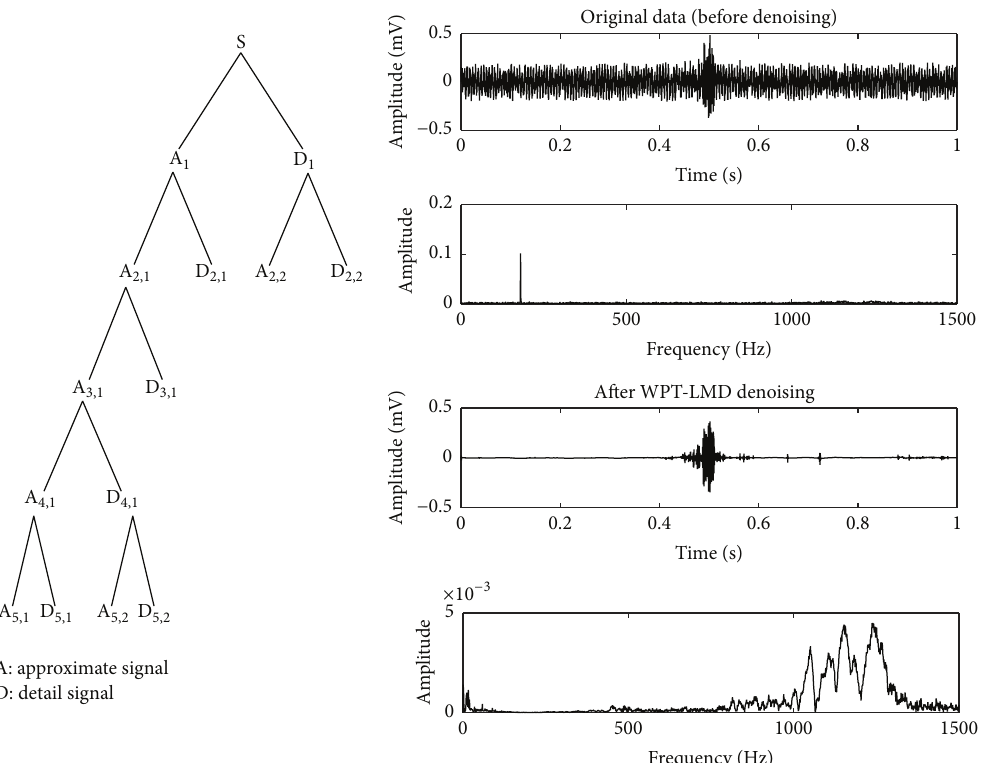
Figure 1: The WPT best tree of CSA2 and denoising effect of WPT-LMD